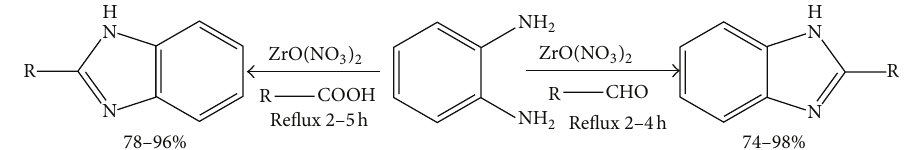
Scheme 1: Zirconyl nitrate-catalyzed synthesis of substituted